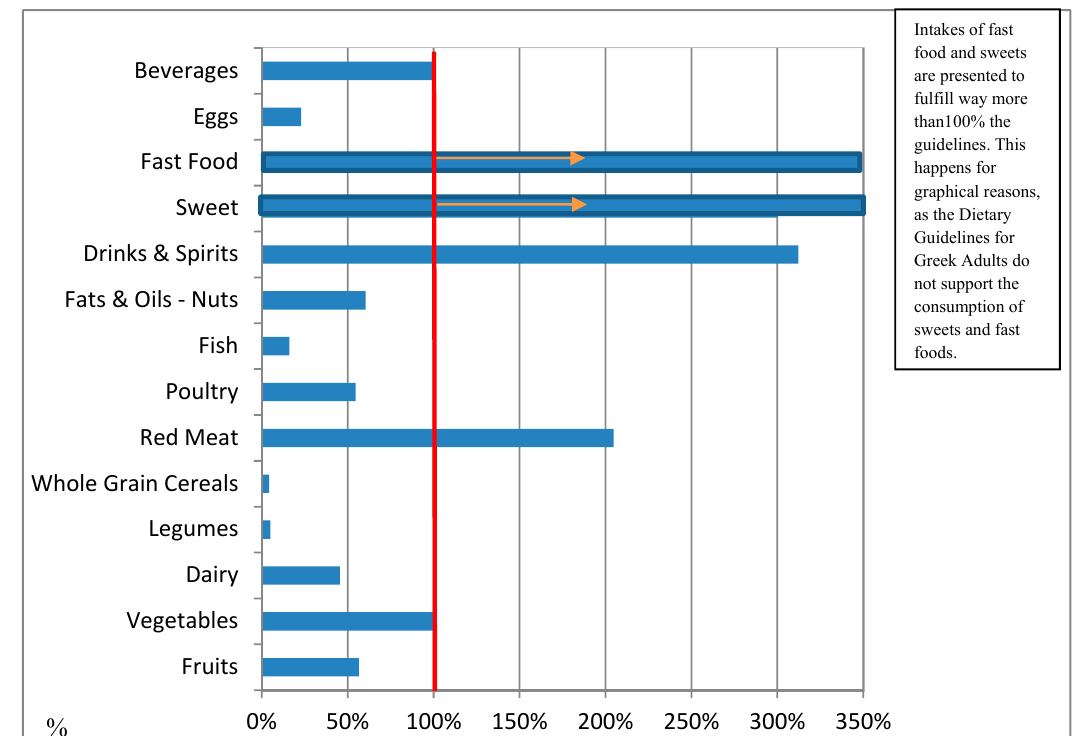
Figure 1. Combined 24 hR with FPQ’s intakes of Greek males and agreement with the Dietary Guidelines for Greek Adults. The percentages of agreement were calculated from the combined intakes (grams/day) of food groups in relation to reported frequency of intake (FPQ) and reported amount of intake (24 hR) of Greek males and the Dietary Guidelines for Greek Adults. The red line represents the point at which guidelines are fulfilled.